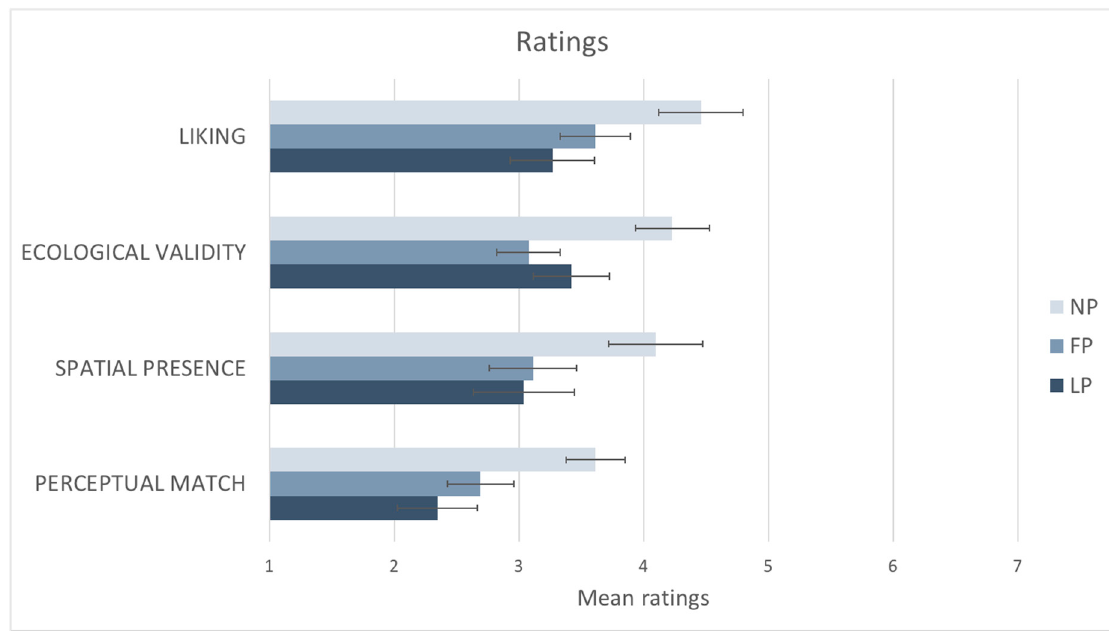
Figure 7. The graph reports the average ratings ( N = 26) on a 7-point Likert scale for each photograph: Natural (NP), Fisheye (FP) and Linear (LP). Standard errors are represented in the figure by the error bars attached to each